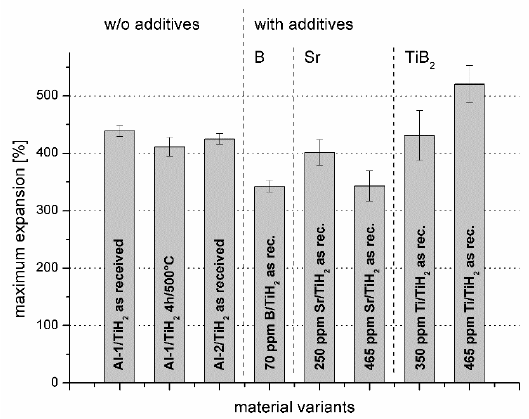
Figure 8. Maximum expansion of various precursor material variants, highlighting the influence of additive type and content.